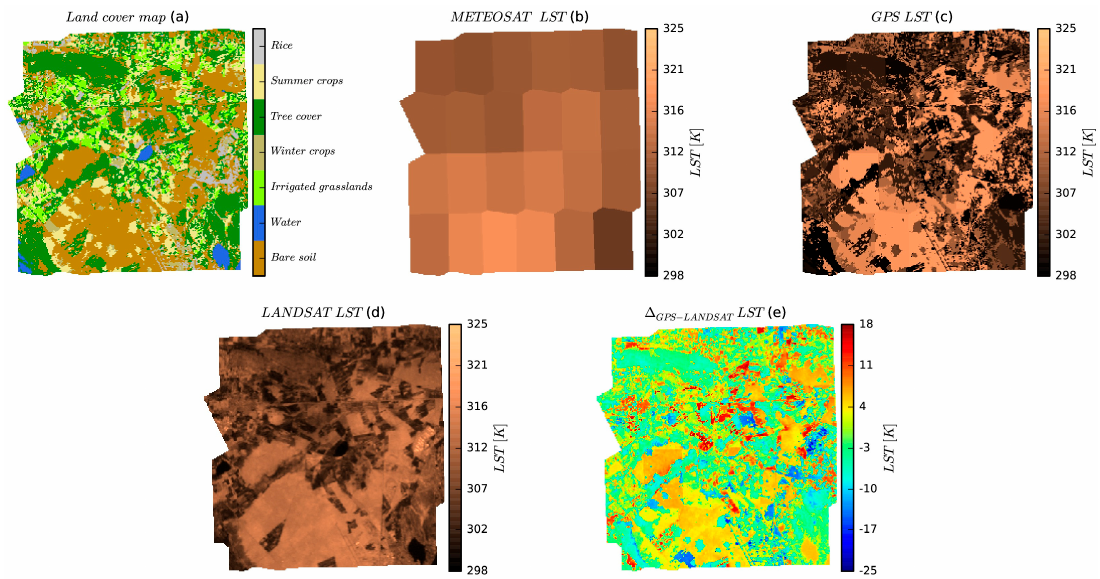
Figure 3. GPS downscaling results at 60 m resolution over a small part of the studied area for the DOY 240: ( a ) land cover dominant class; ( b ) Meteosat LST; ( c ) GPS LST; ( d ) Landsat 7 LST; and ( e ) map of the differences between GPS and Landsat 7. Meteosat data was acquired at 10:15 UTC and Landsat 7 at 10:20